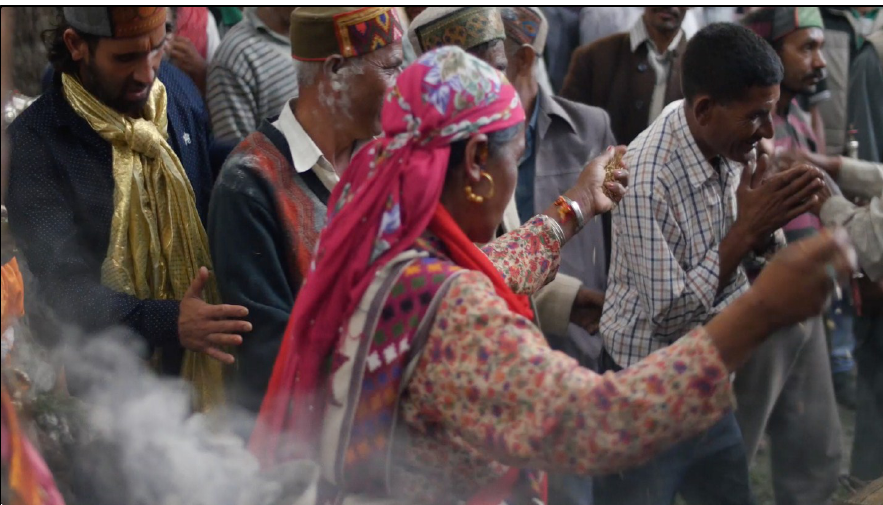
Figure 6. The Naran leading in dance towards the site of the killing ( Narbali ). Religions 2018 , 9 , x FOR PEER REVIEW